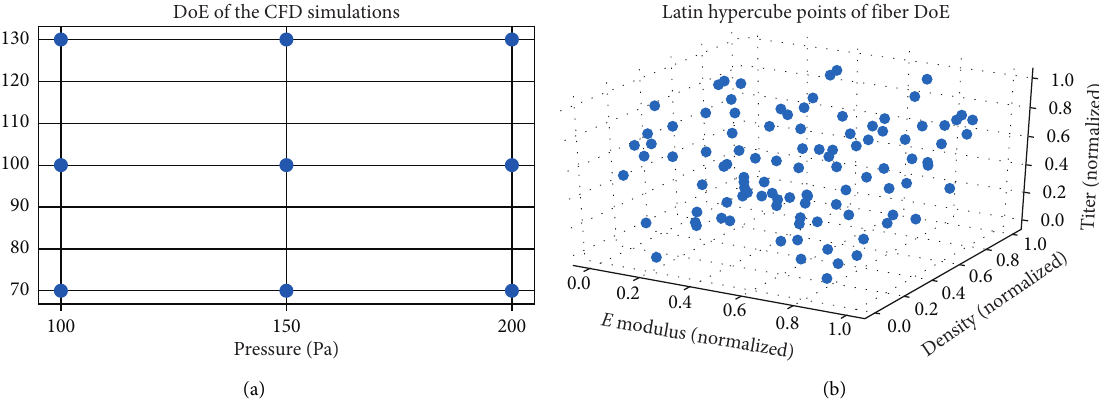
Figure 3: (a) Design of experiments for the CFD simulations. (b) Distribution of the 100 Latin Hypercube points of the fiber Doe: the original range of the E modulus is 10GPa to 30GPa, the density range 900g/cm 3 to 1200g/cm 3 , and the line density (titer) range 2.83 dtex to 4.53 dtex. A simulation has been performed for each parameter combination corresponding to the points in the cube. For better visu- alization, the values are plotted in a normalized range between 0 and 1.